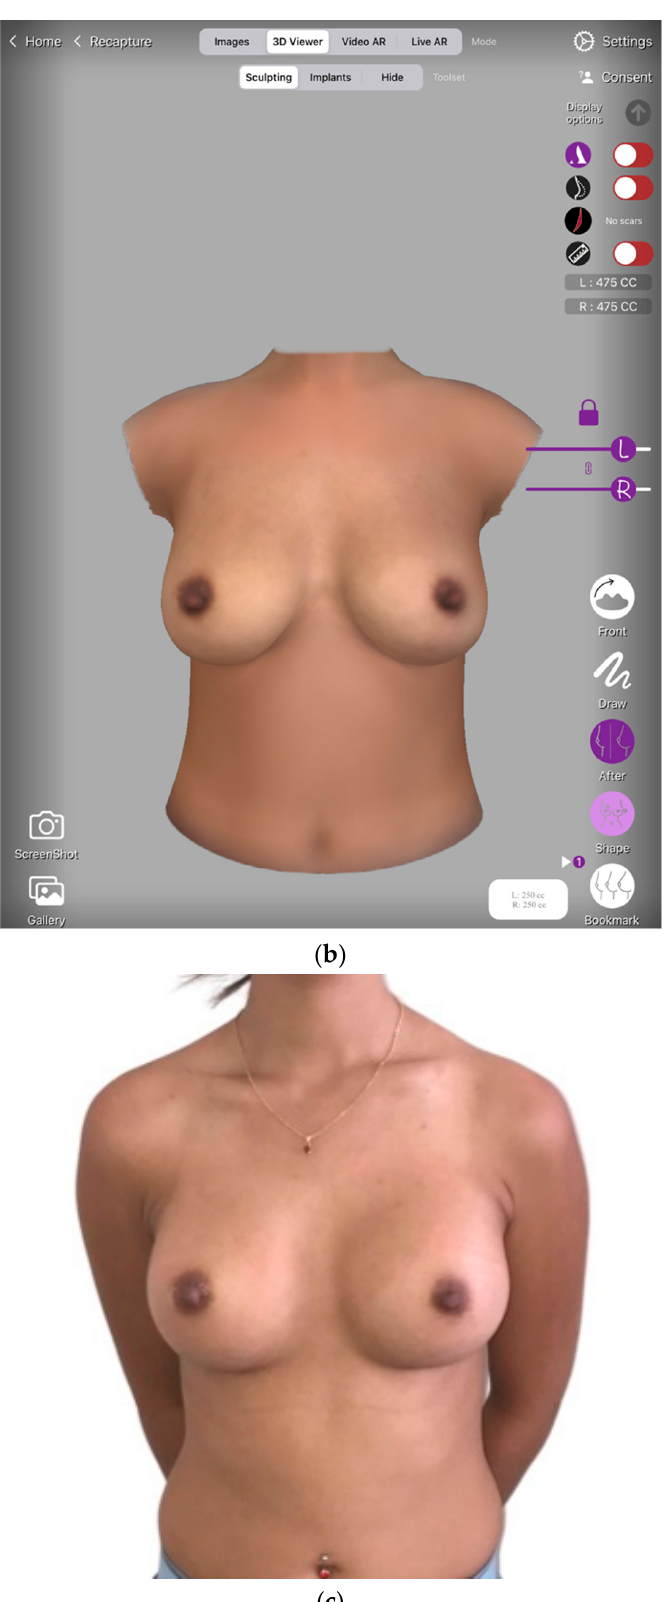
Figure 2. ( a ) Pre-operative photograph of a 25-year-old patient. ( b ) 3D breast augmentation simula- tion. Implant positioning was selected on a prepectoral plane. ( c ) Post-operative photograph of the same patient at the one-year follow-up.